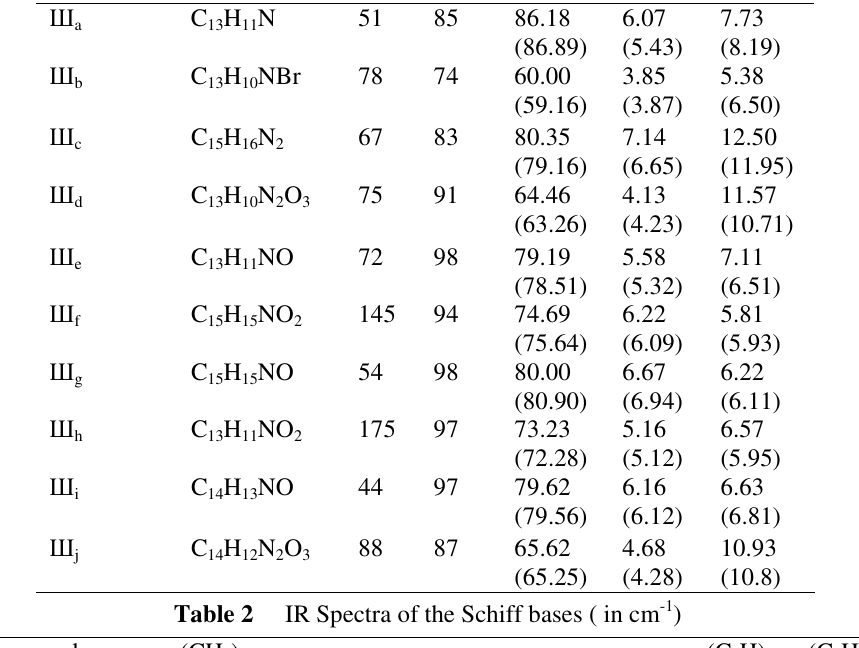
IR Spectra of the Schiff bases ( in cm -1